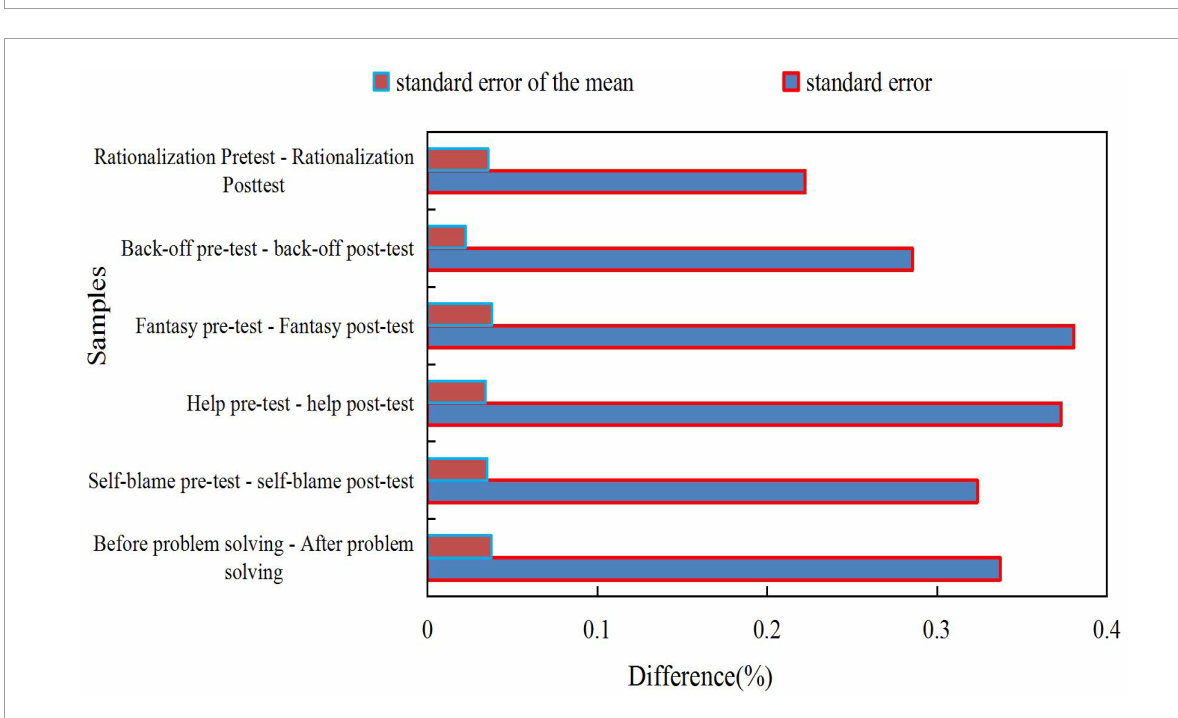
FIGURE6 Students’ learning purpose and motivation.